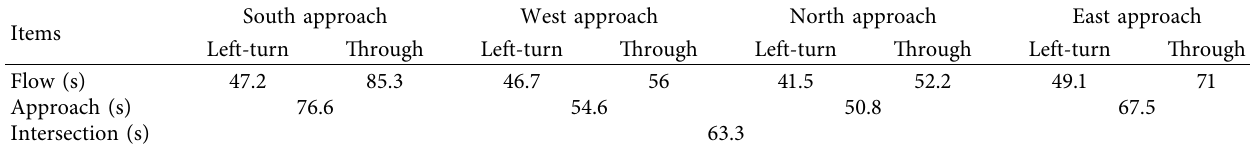
Table 3: Simulation delay of the current intersection signal control scheme.